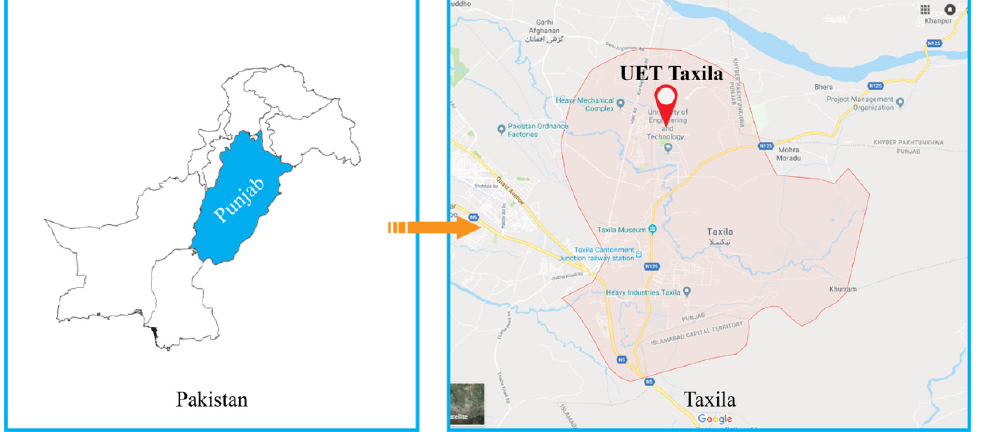
Figure 1. Map of the study area [source: GoogleMaps©].